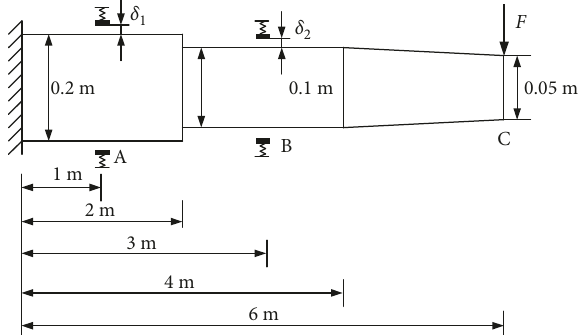
Figure 33: Nonlinear clamped beam structure.